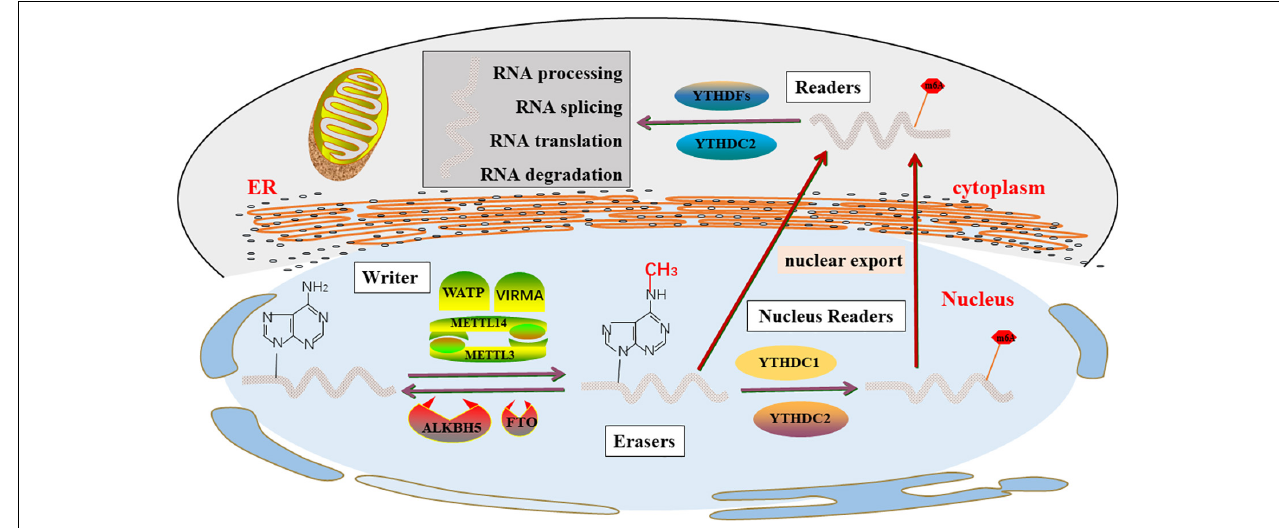
FIGURE 1 | m6A enzyme molecular mechanisms in detail. The “writers”, “Erasers”, and “Readers” rely on a variety of related factors to cause m6A modifications through installation, removal and combination and involved in RNA metabolism, including processing, degradation, splicing, and